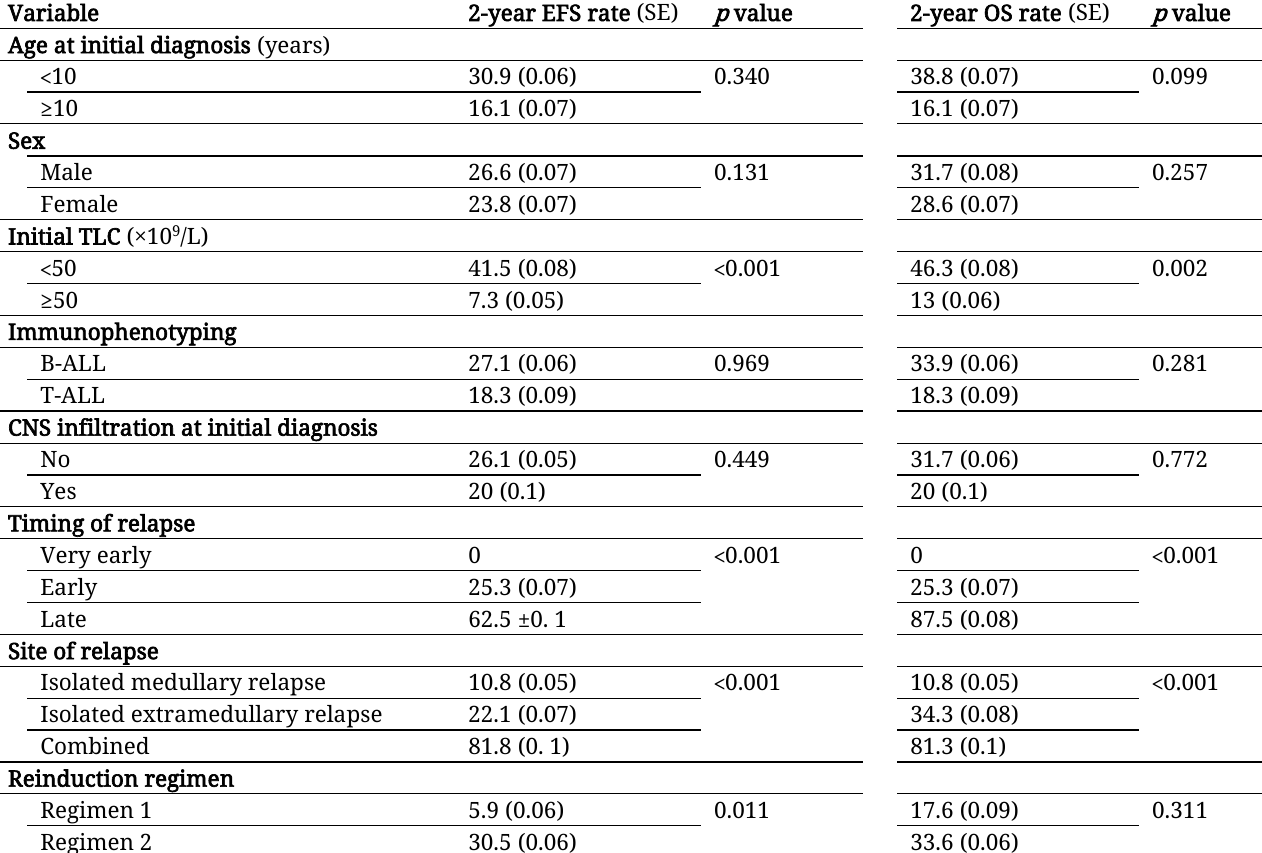
Table 3: The relationship between variables and event-free and overall survival after first relapse in children with acute lymphoblastic leukemia